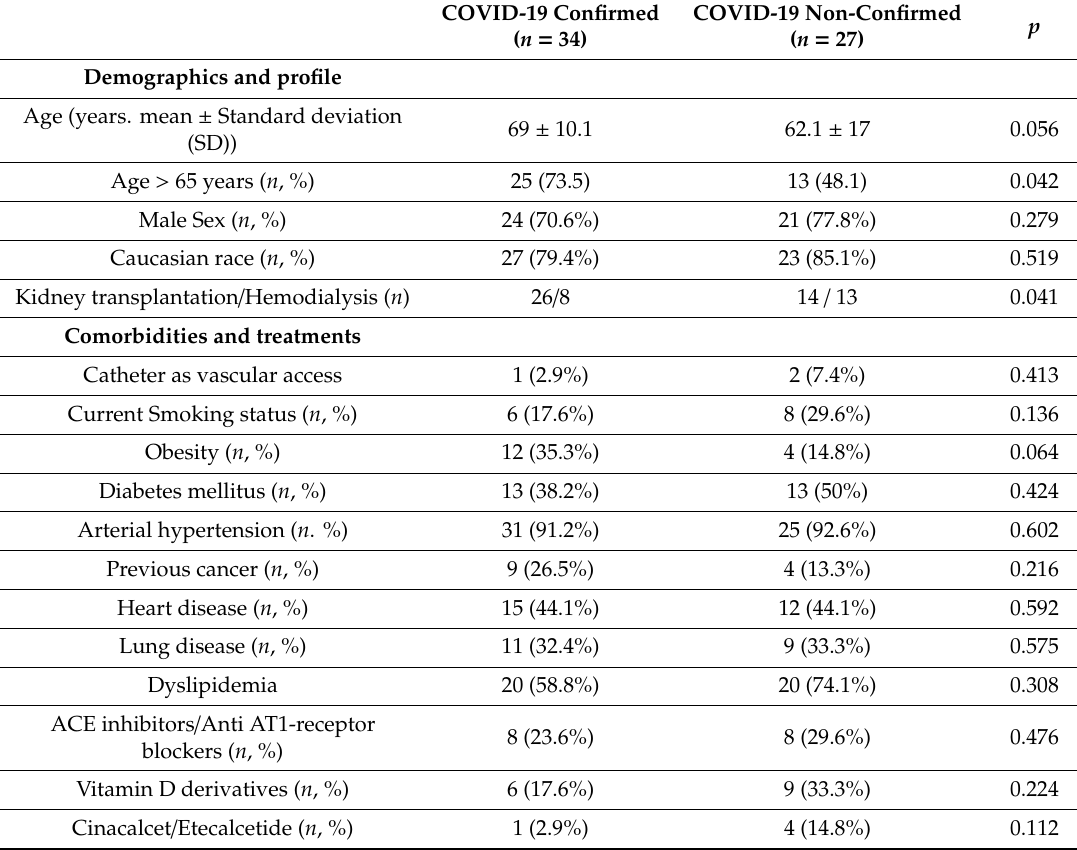
Table 1. Baseline characteristics of COVID-19 confirmed and non-confirmed